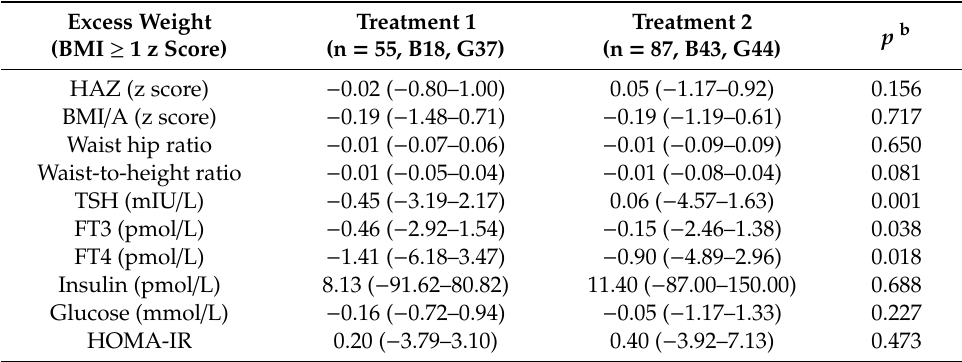
Table 2. Delta between baseline and follow-up of anthropometric and metabolic variables in both interventions a